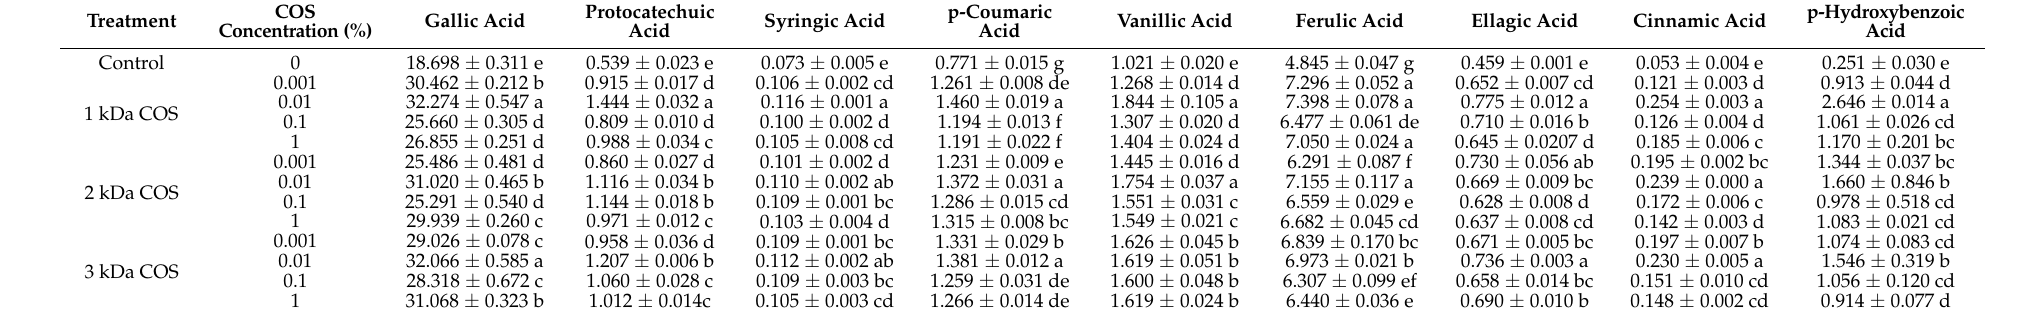
Table 1. Phenolic components concentration (mg/g dry weight) of soybean sprouts under different chitooligosaccharide treatments.